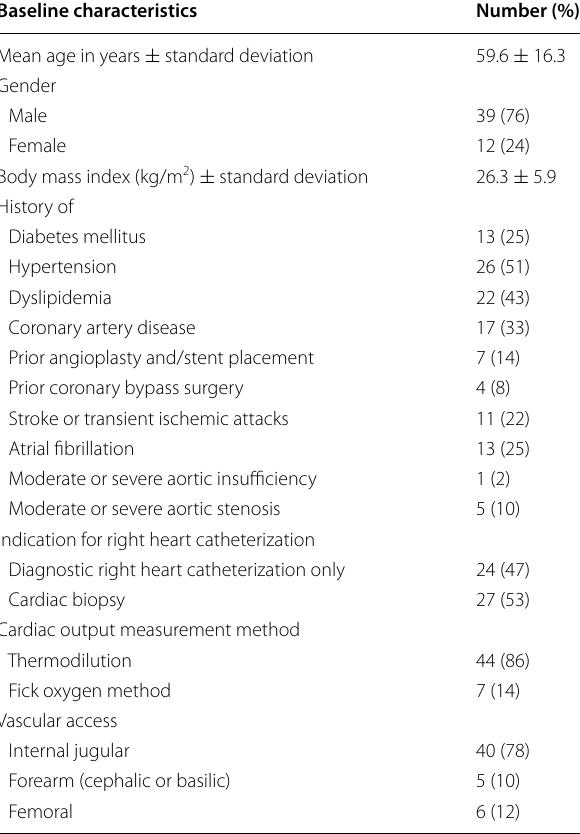
Table 1 Baseline characteristics of 51 patients included